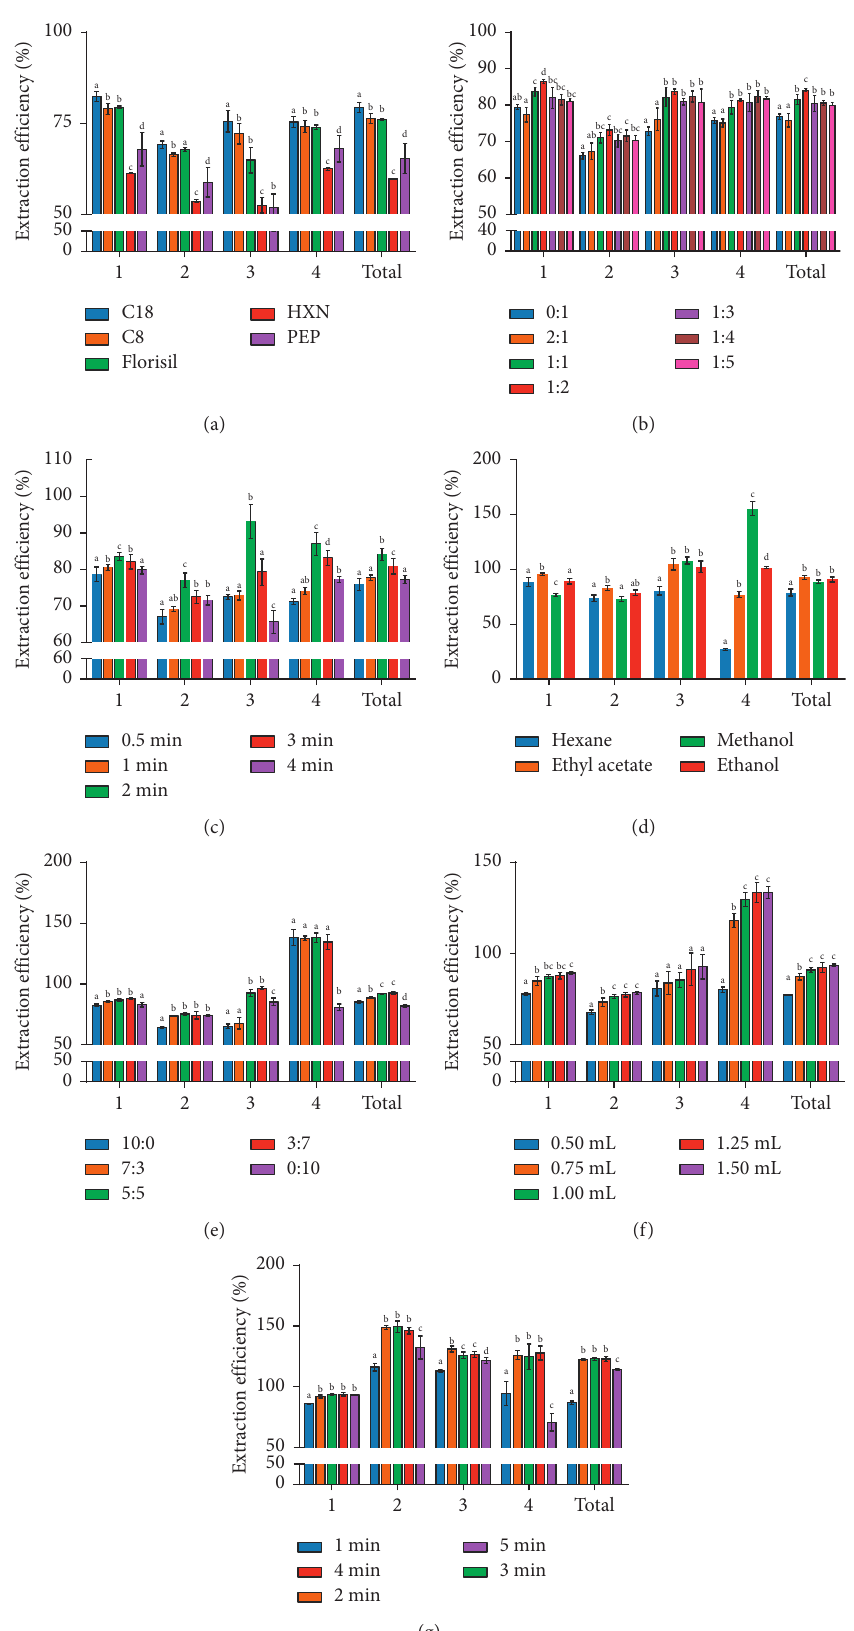
Figure 4: Effects of parameters on the efficiency of 4 contents.1: muscone; 2: ethyl palmitate; 3: ethyl oleate; 4: ethylparaben. (a) Type of the dispersant. (b) Ratio of sample to dispersant. (c) Grinding time. (d) Type of eluent solvent. (e) Proportion of binary eluent. (f) Volume of binary eluent. (g) Vortex